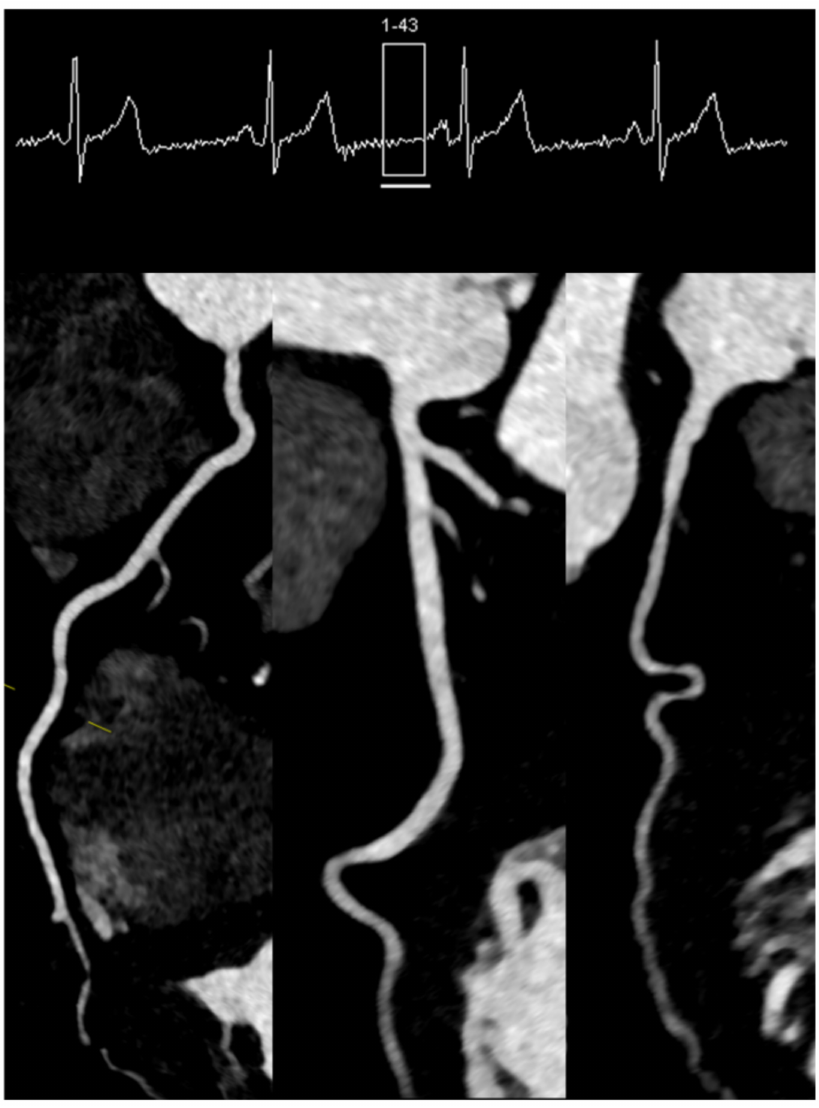
Figure 3. High-pitch dual source spiral protocol (“Flash” mode) in a patient with a stable heart rate of